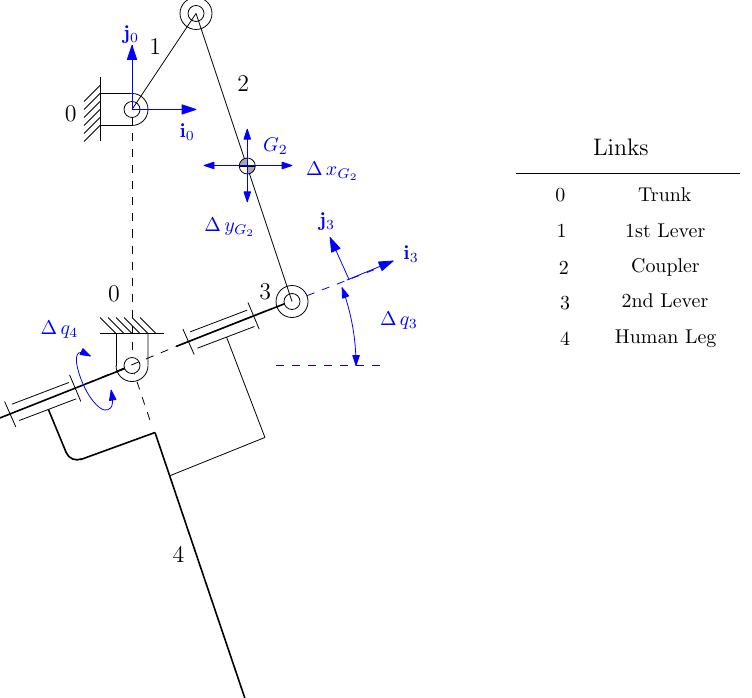
Figure 3. The kinematic diagram of a substructure of the exoskeleton for the lower